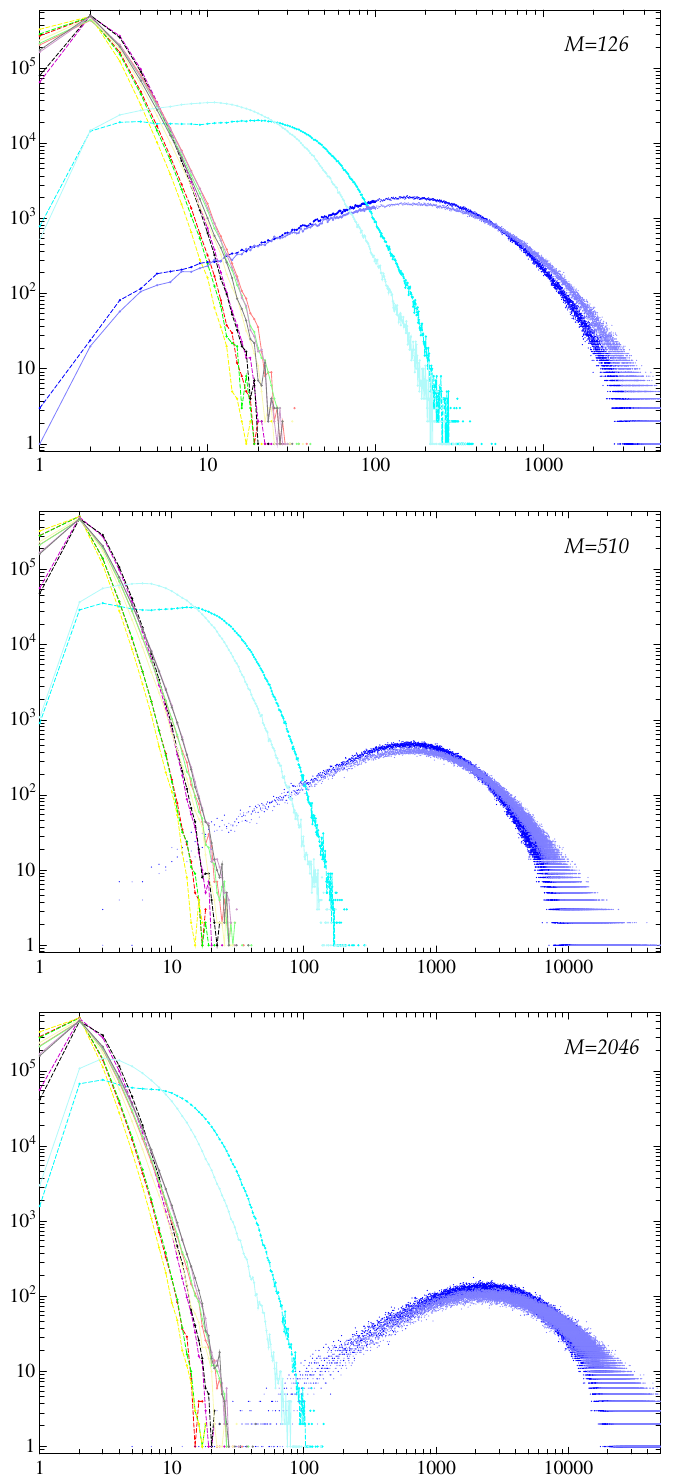
Figure 3. Distribution of error norms of approximate solutions obtained for 10 6 test problems by algorithms 1 (red), 1 (cid:48) (green), 2 (blue), 2 (cid:48) (yellow), 3 (cyan), 3 (cid:48) (magenta) and 4 (black colour, respectively) for determining the coefficients of a linear combination of T (cid:63) n ( x 3 ) . Horizontal axis: the error norms relative to the smallest error norm obtained for the test problem by the seven ( k ) algorithms, m ; vertical axis: the number of cases, N m , for the k th algorithm and each error norm. Dashed lines, saturated colours: the maximum error norm; continuous lines, diluted colours: the energy error norm. The panels show the plots for the three values of the resolution parameter M